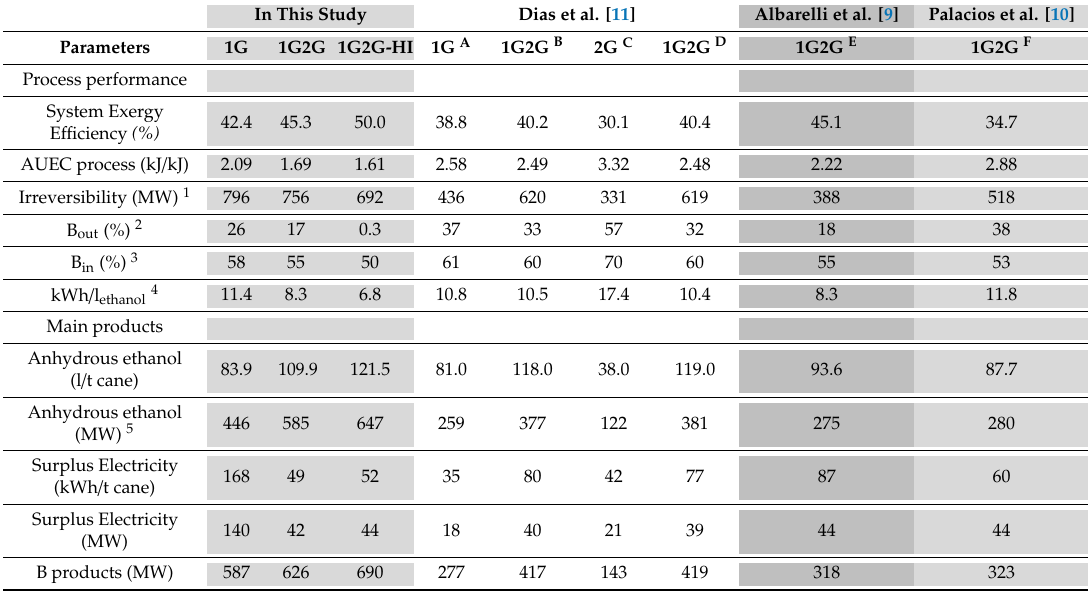
Table 4. Performance comparison of the di ff erent